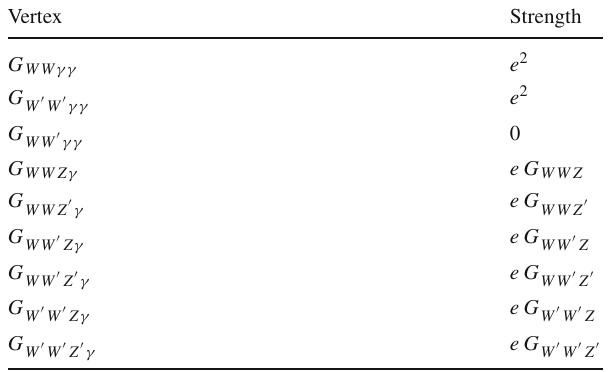
Table 8 Neutral current interactions in the model calculated to O ( x 2 ) Coupling